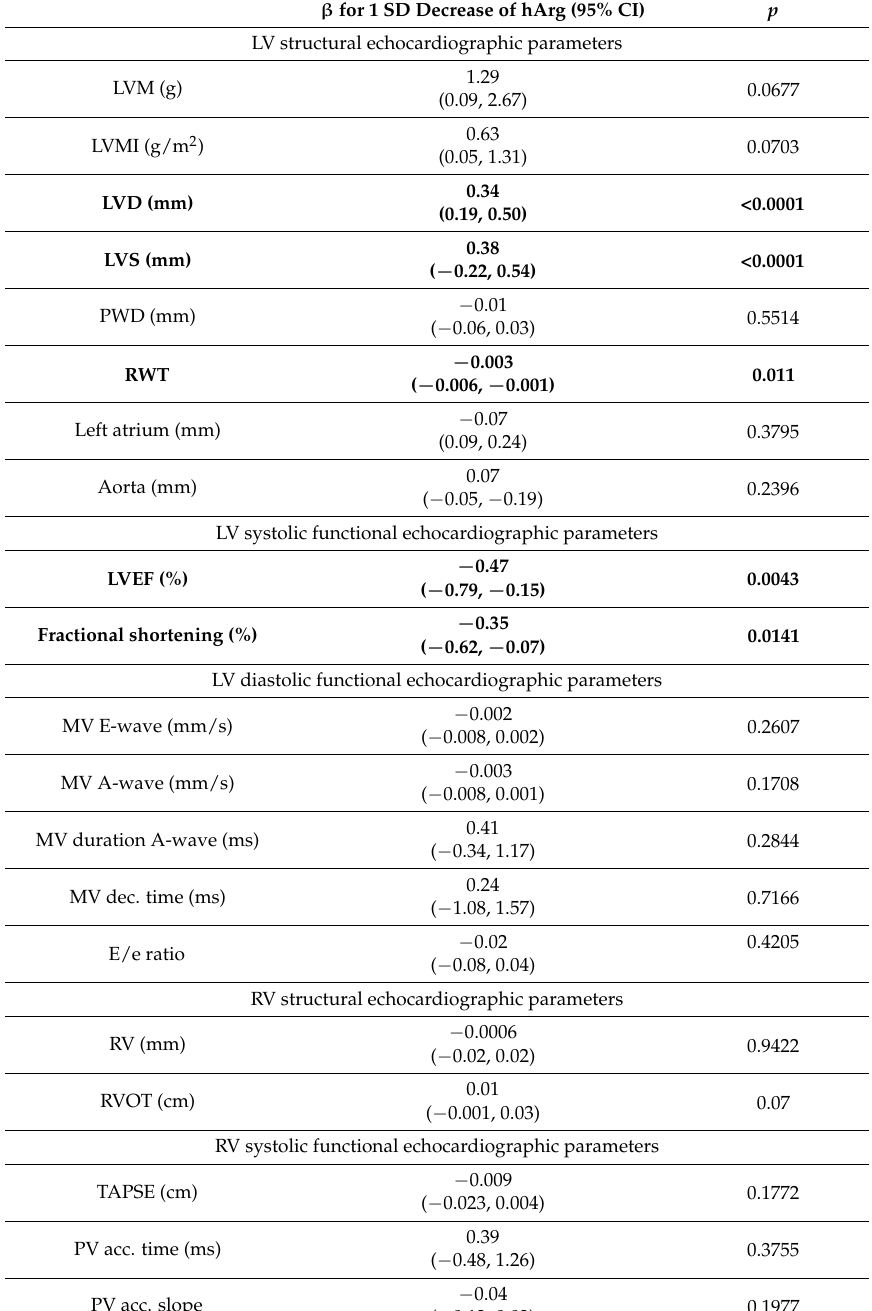
Table 2. The relation between hArg and cardiac structure and function. The outcomes were analyzed by linear regression adjusted for sex, age, BMI, and eGFR. Bold lettering indicated p < 0.05. β for 1 SD Decrease of hArg (95% CI) p LV structural echocardiographic